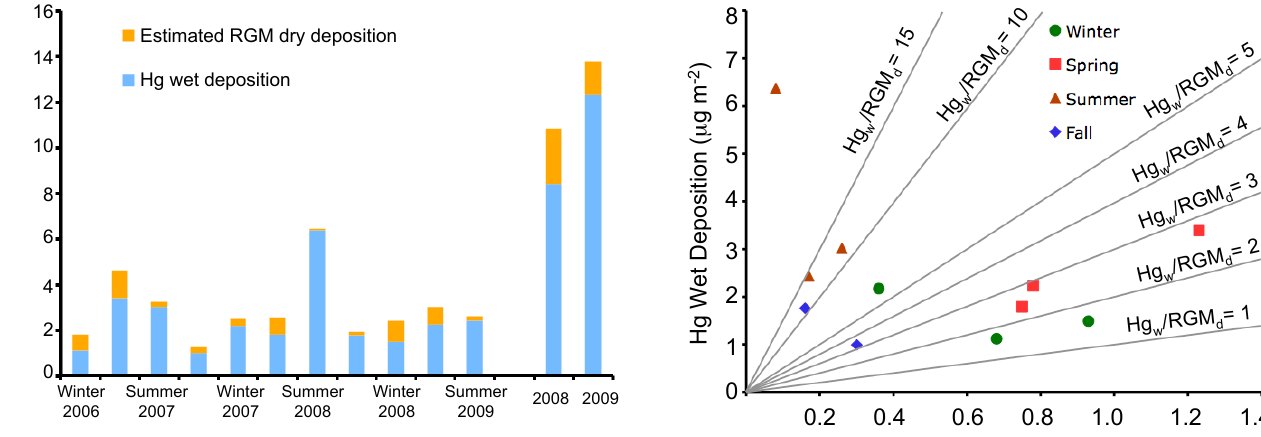
Fig. 5. Seasonal and annual Hg wet deposition and estimated RGM dry deposition at TF.